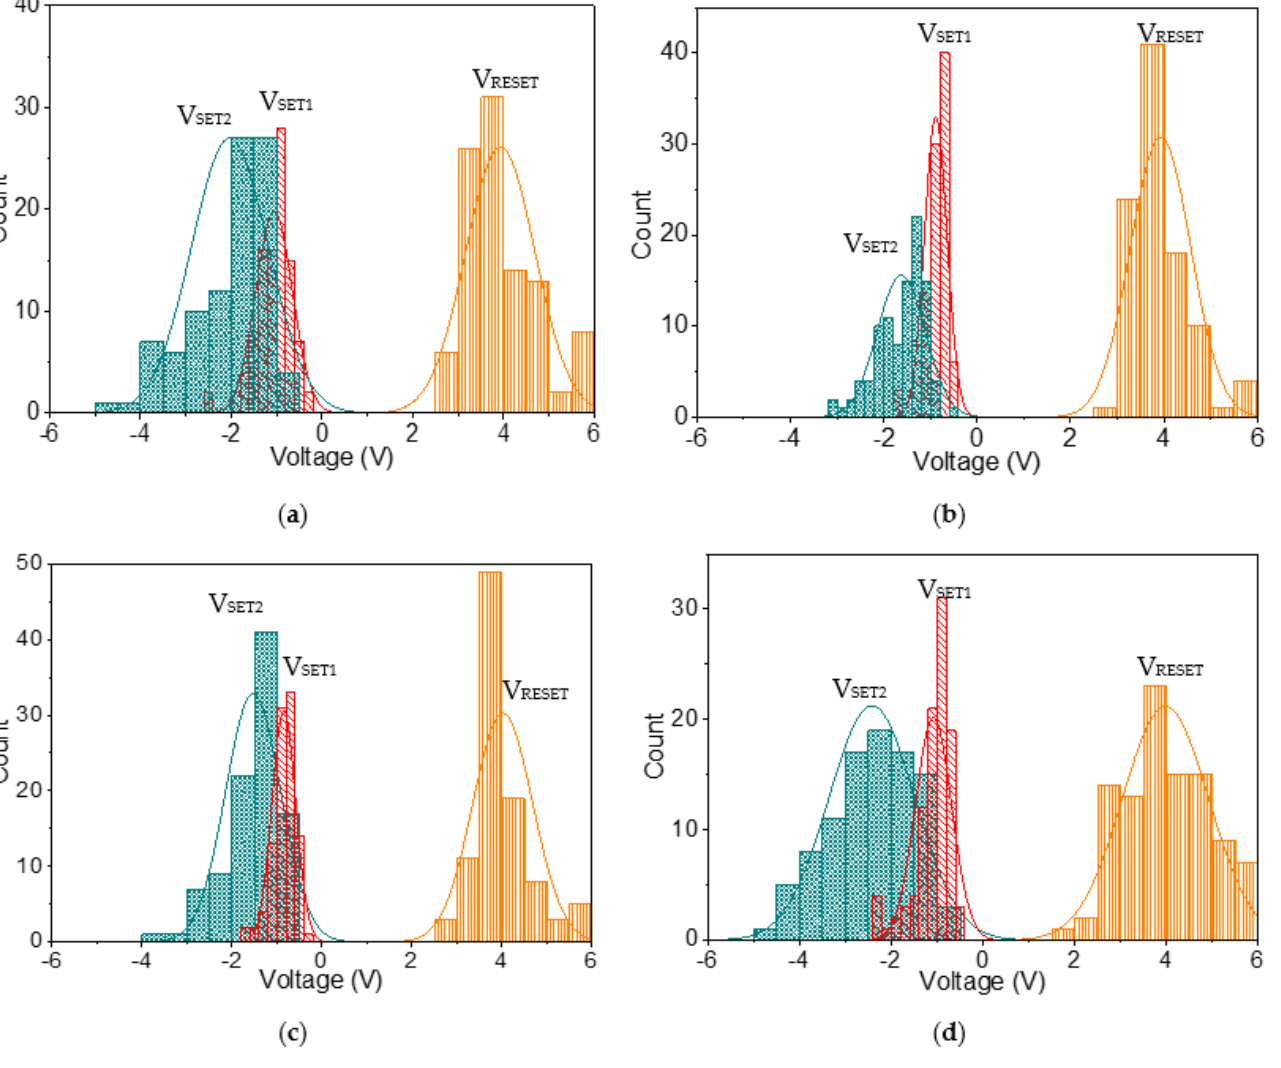
Figure 10. Histogram curves of V SET1 , V SET2 , and V RESET for ( a ) ITO/B1/Ni, ( b ) ITO/B2/Ni, ( c ) ITO/B3/Ni, and ( d ) ITO/B4/Ni during repeated resistive switching. Table 5. Average of V SET1 , V SET2 , V RESET for cycle-to-cycle analysis.